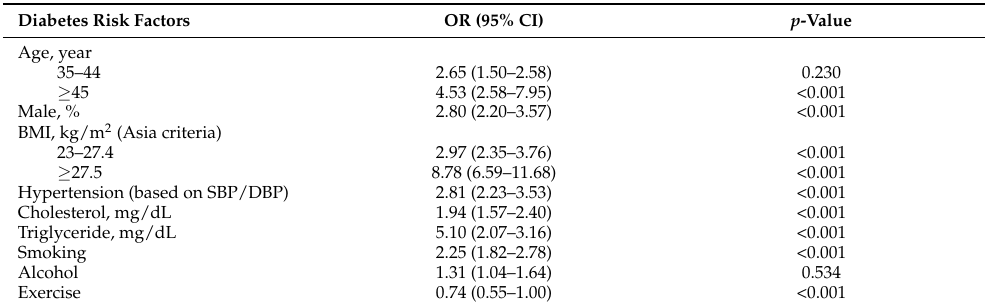
Table 3. Japanese adults’ diabetes score in the Japanese diabetes dataset (373 diabetes cases, n = 15,464, AUC = 0.80).